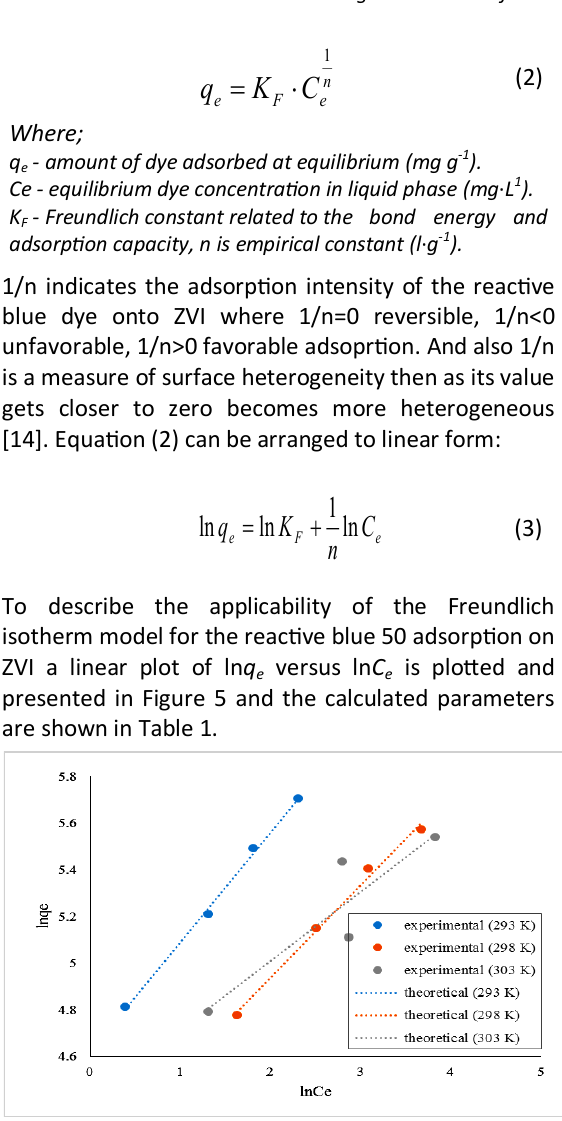
Fig. 5. Linear form of Freundlich isotherm model, experimental condition: рН= 6.0, room temperature 293K